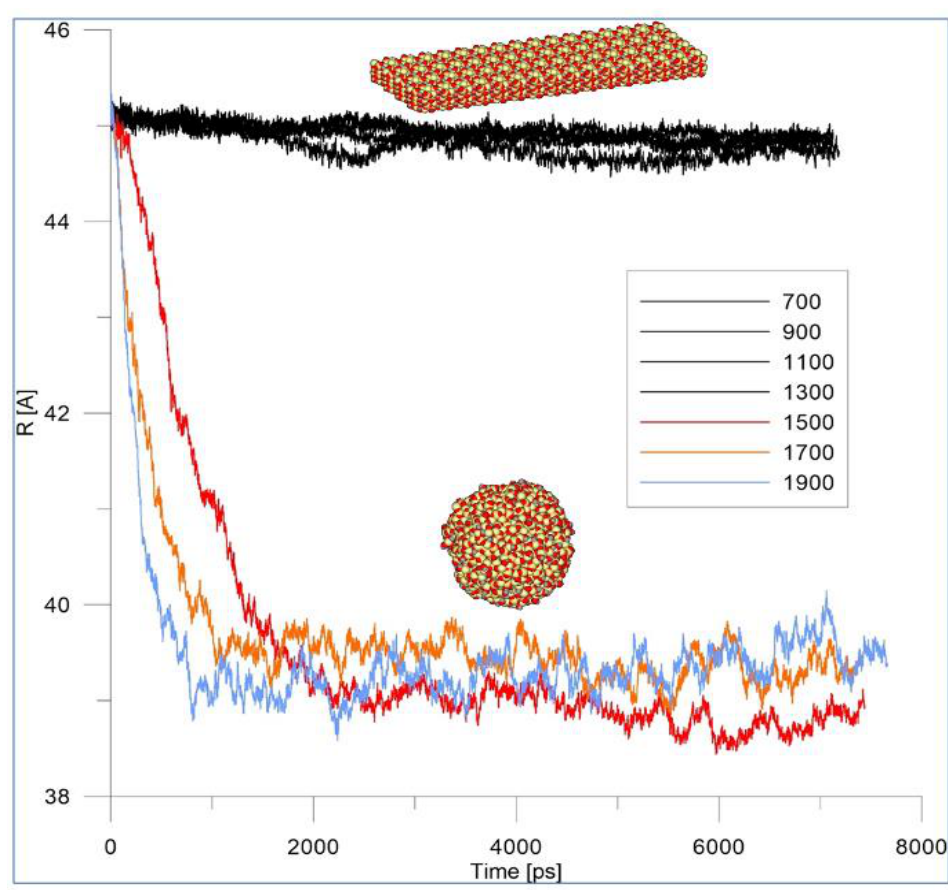
Figure 4. The dependence of the radius of gyration on time for HAP128 cluster of 16 × 4 × 2 super- cells.